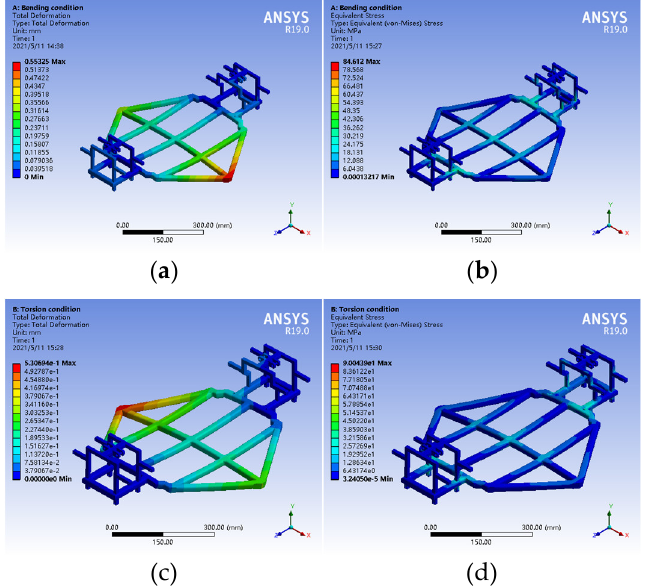
Figure 11. Simulation results of frame under different working conditions. ( a ) Distribution of resultant displacement under full load bending; ( b ) Stress distribution under full load bending; ( c ). Distribution of resultant displacement under full load torsion; ( d ) Stress distribution under full load torsion.